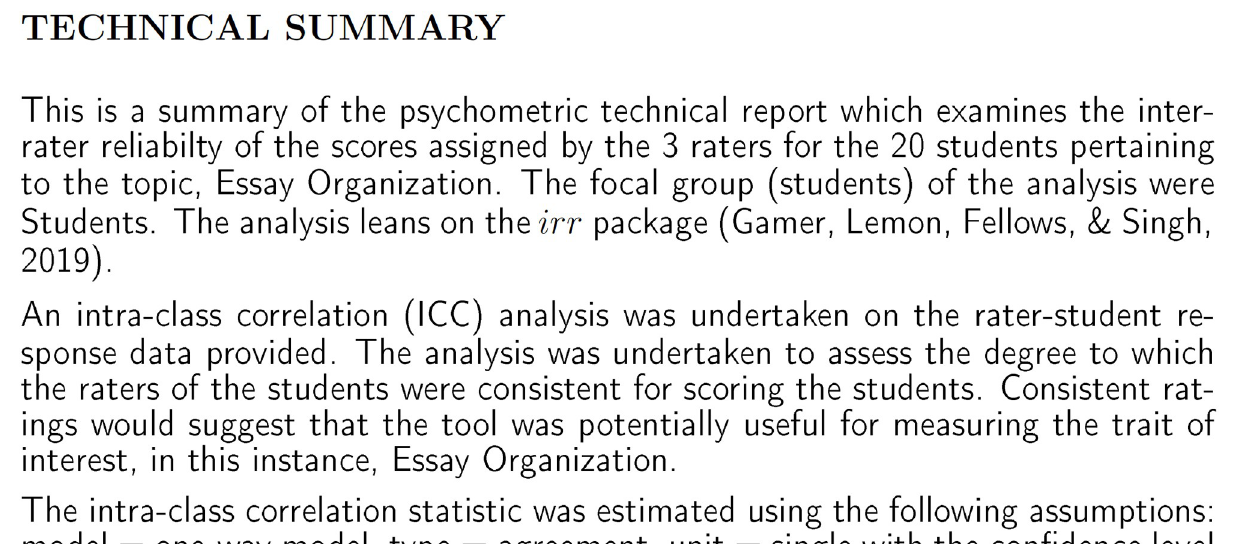
Fig 18. Inter-rater technical summary example as provided by autopsych.